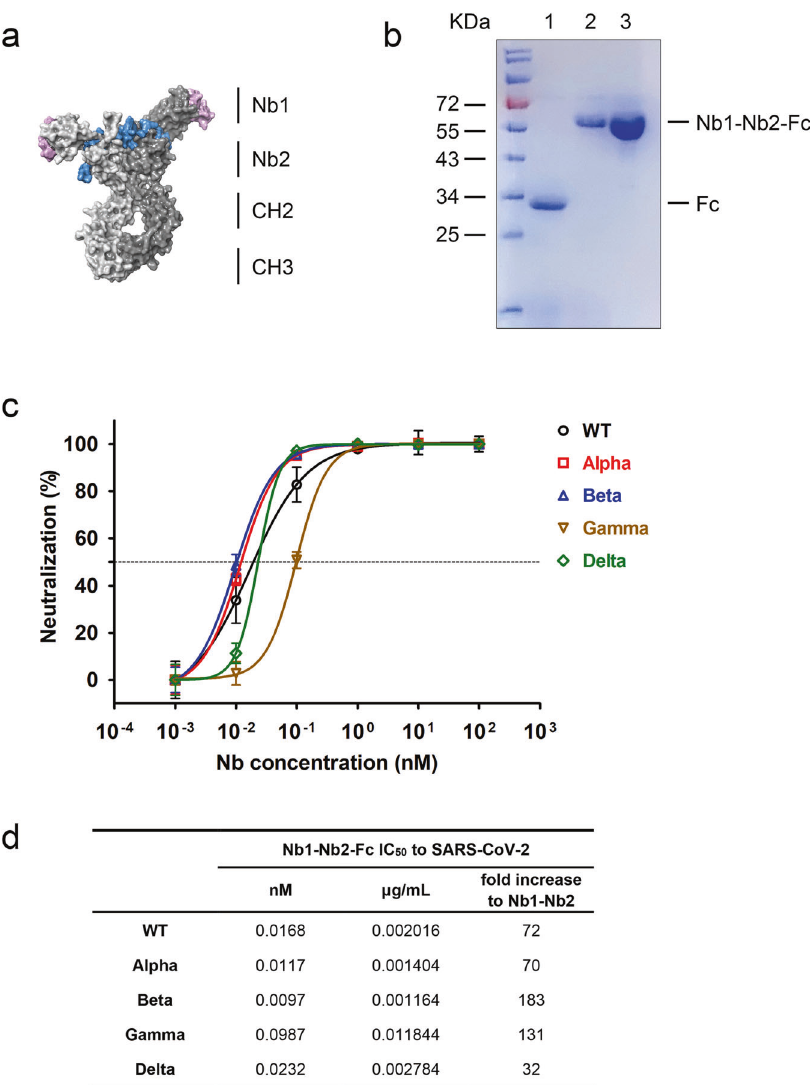
Fig. 5 Enhanced neutralization potency by Fc-fused biparatopic Nb. a Schematic representation of the construction of Nb1 – Nb2 – Fc. Homology modeling of Nb1 – Nb2 – Fc was performed with SWISS-MODEL server. The structure is depicted as surface mode. The CDR regions were colored as pink for Nb1 and blue for Nb2. b Coomassie Blue staining of the Fc vector (lane 1) and Nb1 – Nb2 – Fc plasmid transfected Expi293F supernatants. Lane 3 shows the af fi nity-puri fi ed Nb1 – Nb2 – Fc. Fc fusion to Nb1 – Nb2 generates a heavy-chain antibody with an approximate molecular weight of 60 kDa in reduced condition. c Neutralization of multiple SARS-CoV-2 GFP/ Δ N trVLP variants with Nb1 – Nb2 – Fc. d Summary of neutralization IC 50 value of Fc-fused Nb that was obtained in ( c ). IC 50 fold increases versus the corresponding non-Fc-fused bivalent Nb were